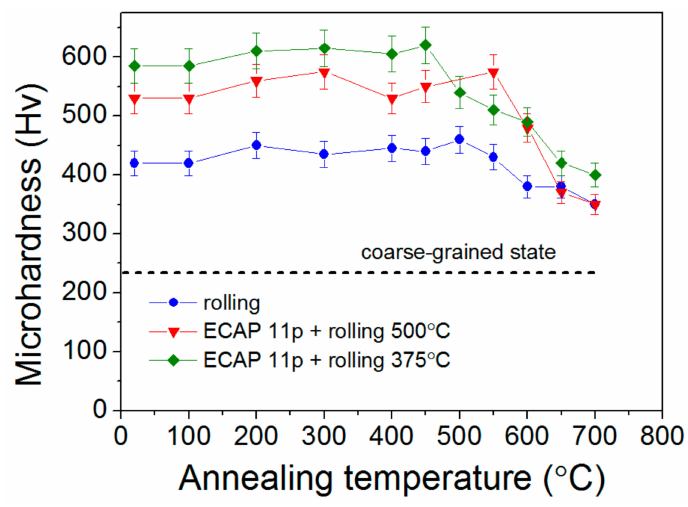
Figure 10. Microhardness of the TWIP steel in different structural states as a function of annealing